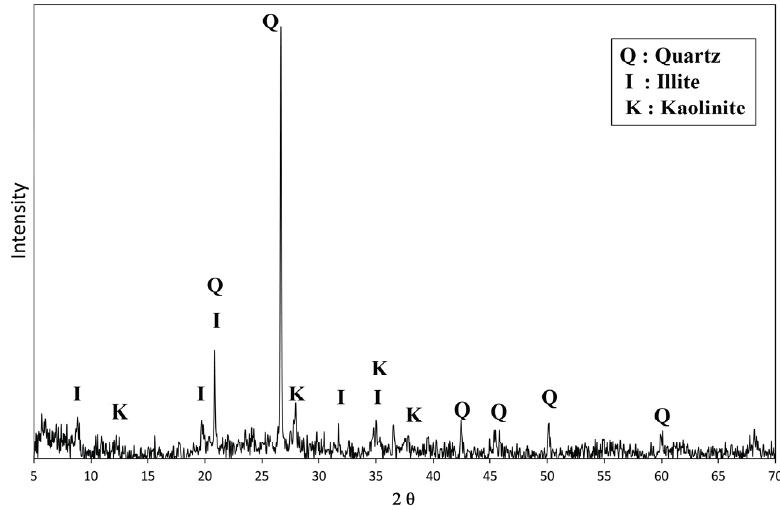
Figure 2. X-ray diffraction (XRD) diffractograms of organic marine clayey